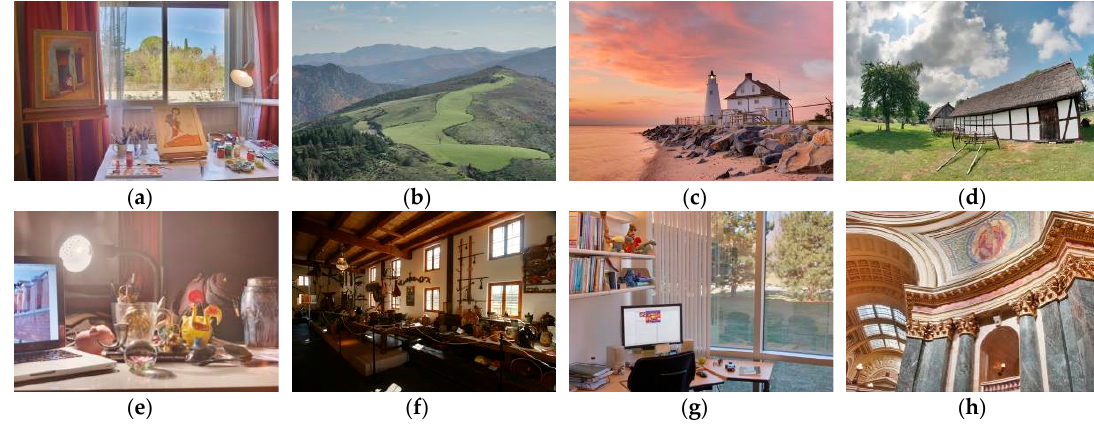
Figure 11. Other fused images of the proposed method. ( a ) Studio EV; ( b ) Landscape; ( c ) Lighthouse; ( d ) Kluki; ( e )desk; ( f ) Farmhouse; ( g ) Office; and ( h ) Madison Capitol.